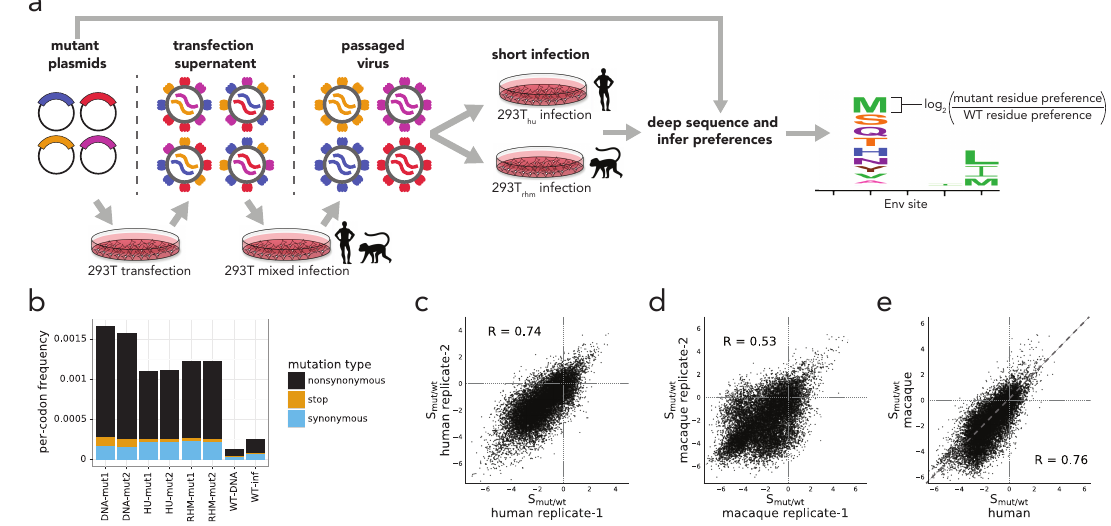
Figure 1. Deep mutational scanning of BF520 Env. ( a ) Schematic of the deep mutational scanning method used. Mutant virus pools were generated by transfection of mutant proviral plasmids followed by low MOI passage. Virus pools were then used to infect either 293T rhm or 293T hu cells. Following infection, amino acid preferences at each Env site were inferred by deep sequencing Env variants from pre- and post-selected samples. Preferences were used to infer S mut / wt values for each mutant as log 2 (mutant preference / wild-type preference), as depicted by the logoplot. ( b ) The bar graph reports the frequencies of nonsynonymous, stop, and synonymous mutations, as indicated in the key to the right. Labels below each bar indicate the stage of library selection (DNA-mut: mutant plasmid DNA; HU-mut and Rh-mut: mutant virus following selection in 293T hu or 293T rhm ; WT-DNA: wild-type plasmid DNA control; WT-inf: wild-type virus control following selecting in 293T hu cells). ( c , d ) Pearson correlations between S mut / wt values from replicate 293T hu infections ( c ) and 293T rhm infections ( d ). ( e ) Pearson correlation between average S mut / wt values from 293T rhm and 293T hu infections. Points above the diagonal grey line indicate mutants that were more advantageous during 293T rhm infection than during 293T hu